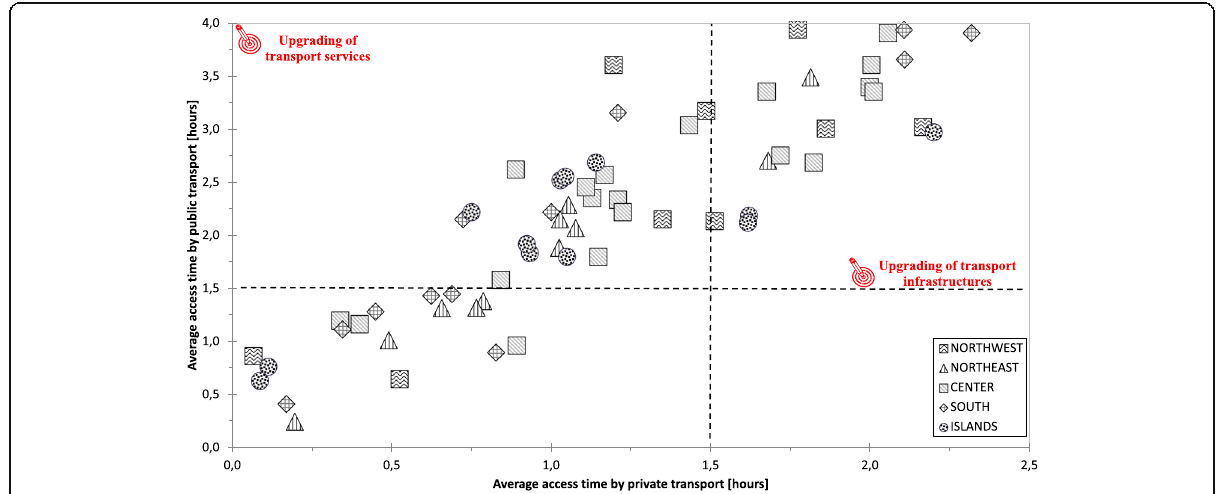
Fig. 10 AG diagram (from the main national